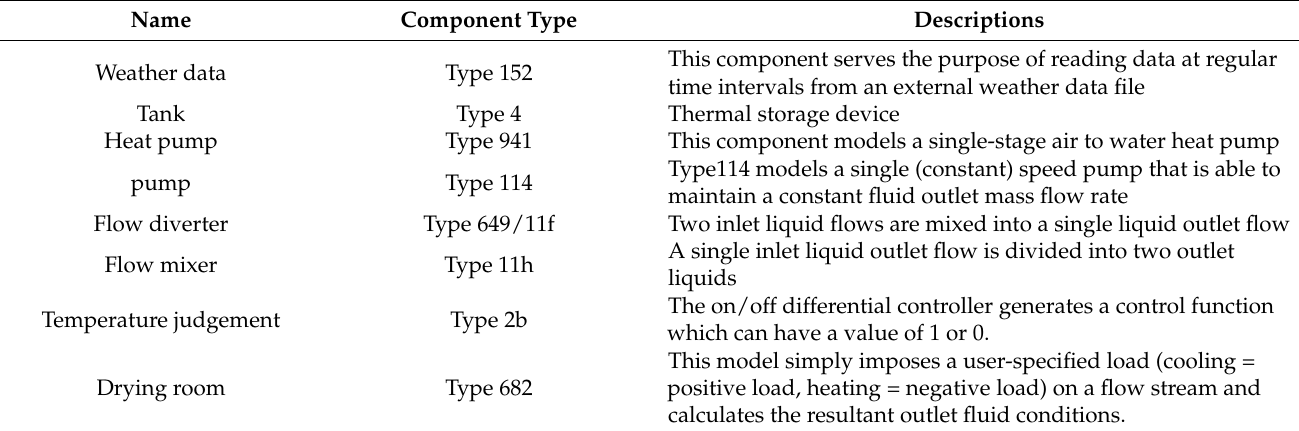
Table 2. Main component in